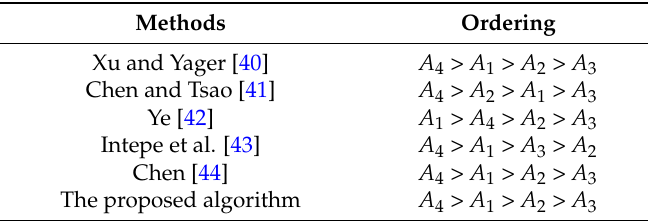
Table 5. Results of the comparative